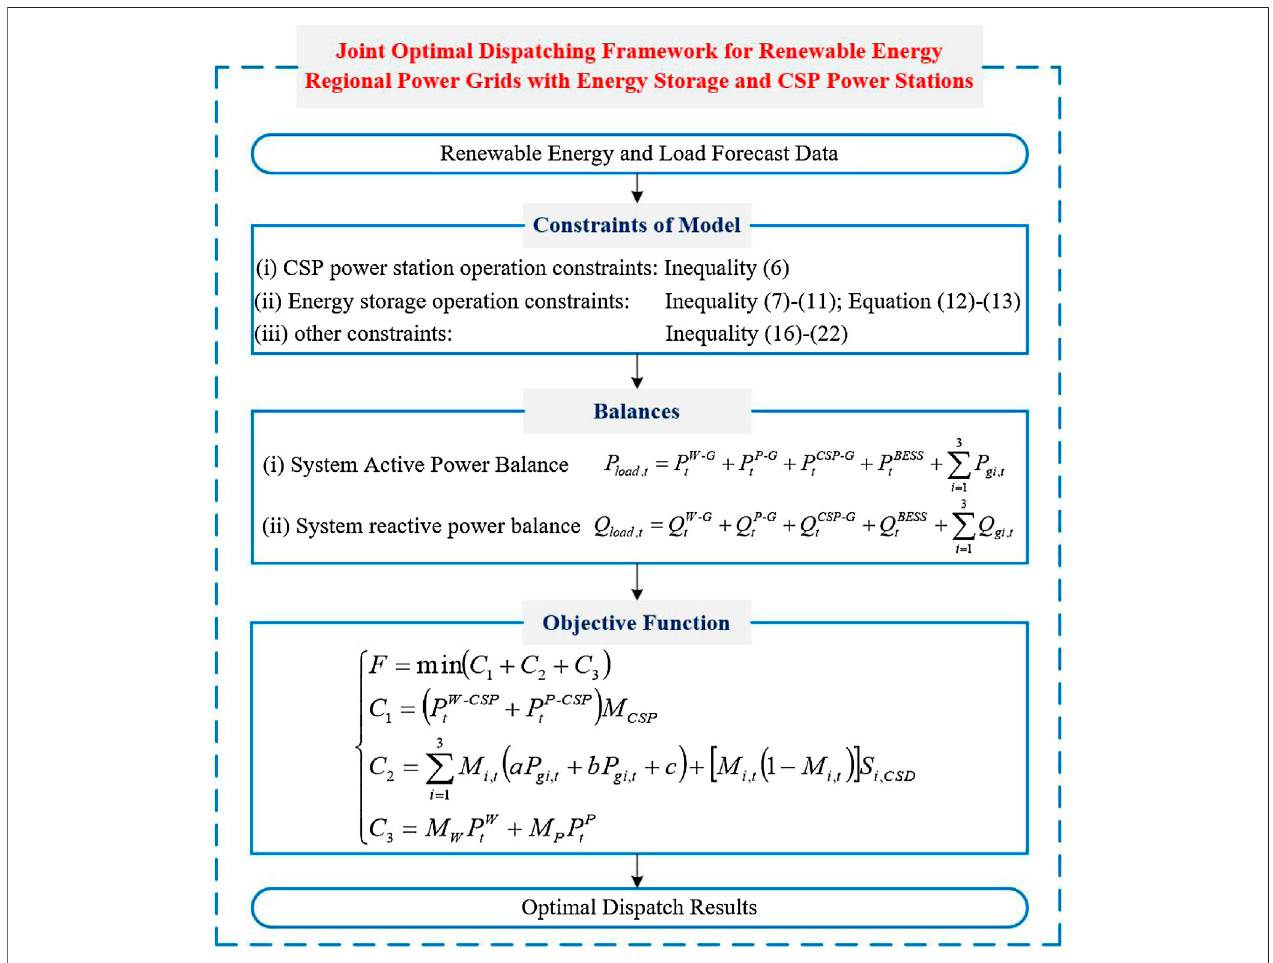
FIGURE 2 | Joint optimal scheduling framework of the renewable energy regional grid with the ESS and CSP plant model.